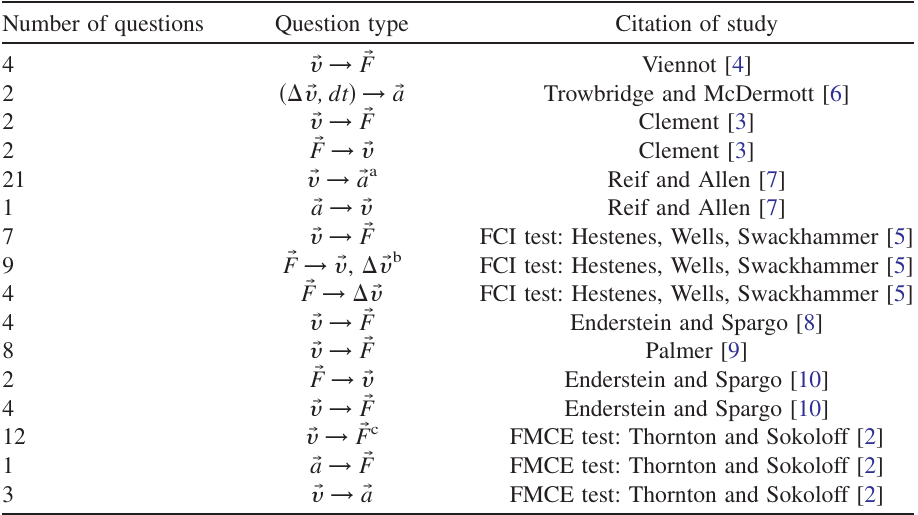
TABLE I. Question types investigated in a sample of previous studies. ( ~x ! ~y notation indicates a question of the form: Given ~x , what can be inferred about ~y